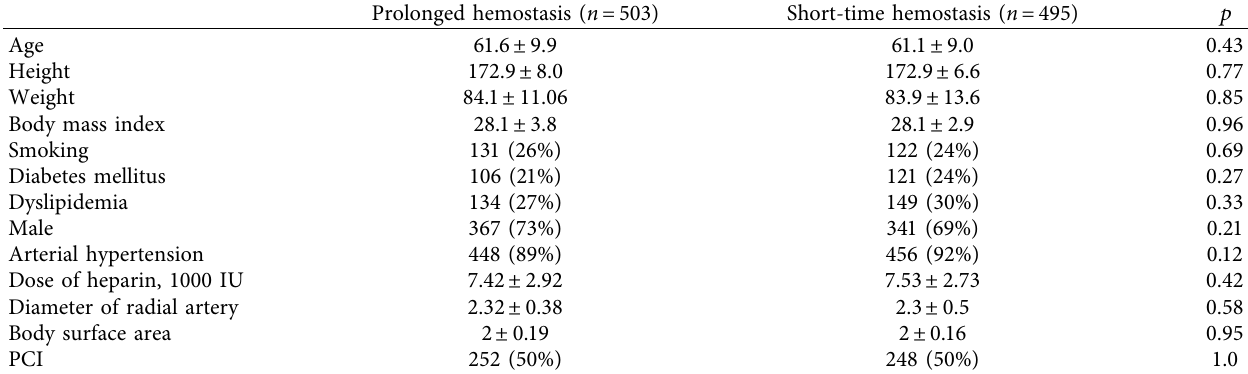
Table 1: Baseline characteristics.